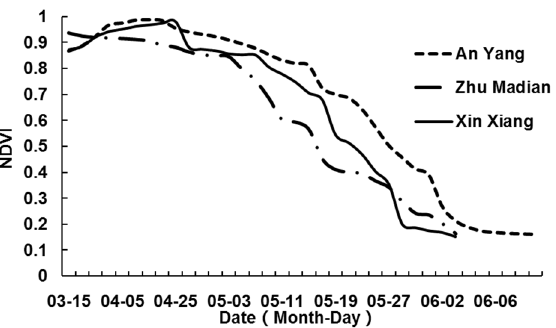
Figure 2. The chart of trend on the NDVI variation measured at the observation points.